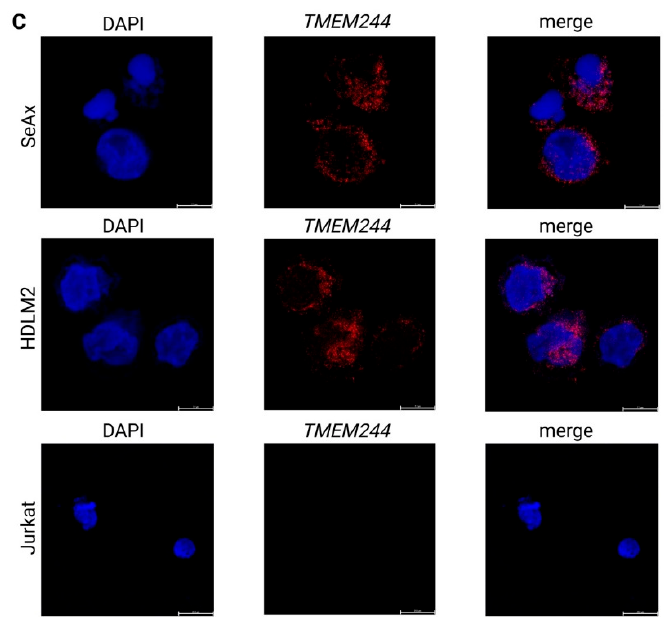
Figure 2. Localization of TMEM244 transcript. ( A ) lncLocator prediction; ( B ) subcellular fractionation and RT-qPCR analysis of TMEM244 expression in SeAx and HDLM2 cells; tRNA lys, RPPH1, and DANCER were used as cytoplasmic controls; U3SNORNA and ANRIL-nuclear controls; KTN1_AS1_ and KTN1_AS1_intron-chromatin controls. The mean values ± SD of 3 independent experiments are shown ( C ) FISH analysis of TMEM244 in SeAx, HDLM2 and Jurkat cells (negative control); TMEM244 FISH signal in red, DAPI counterstain in blue.